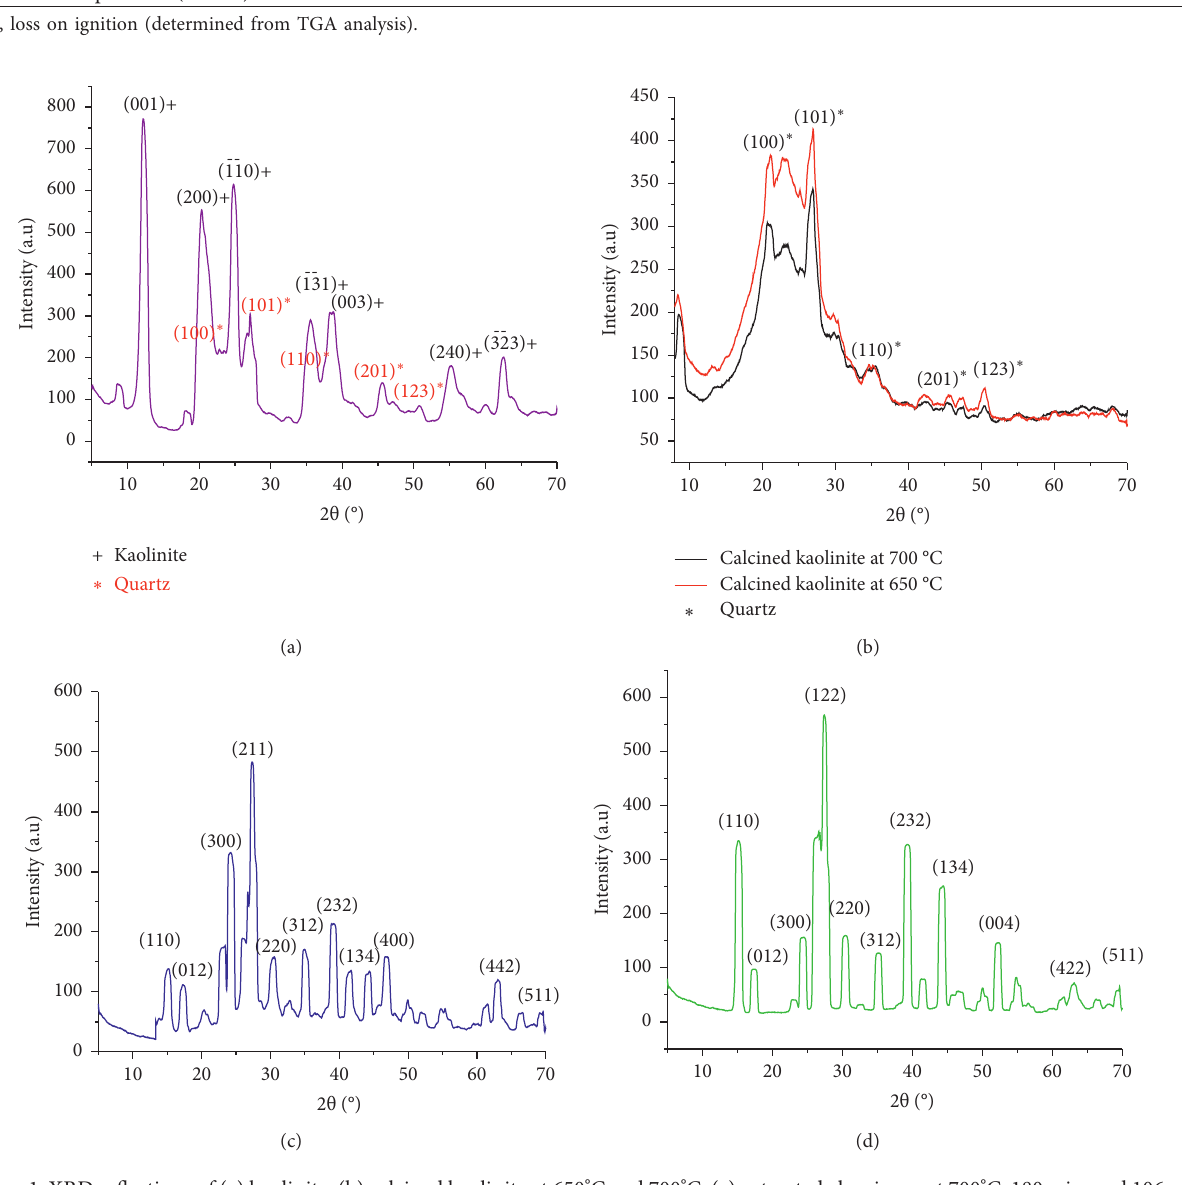
Figure 1: XRD reflections of (a) kaolinite, (b) calcined kaolinite at 650 ° C and 700 ° C, (c) extracted aluminum at 700 ° C, 180min, and 106 μ m, and (d) standard aluminum chloride